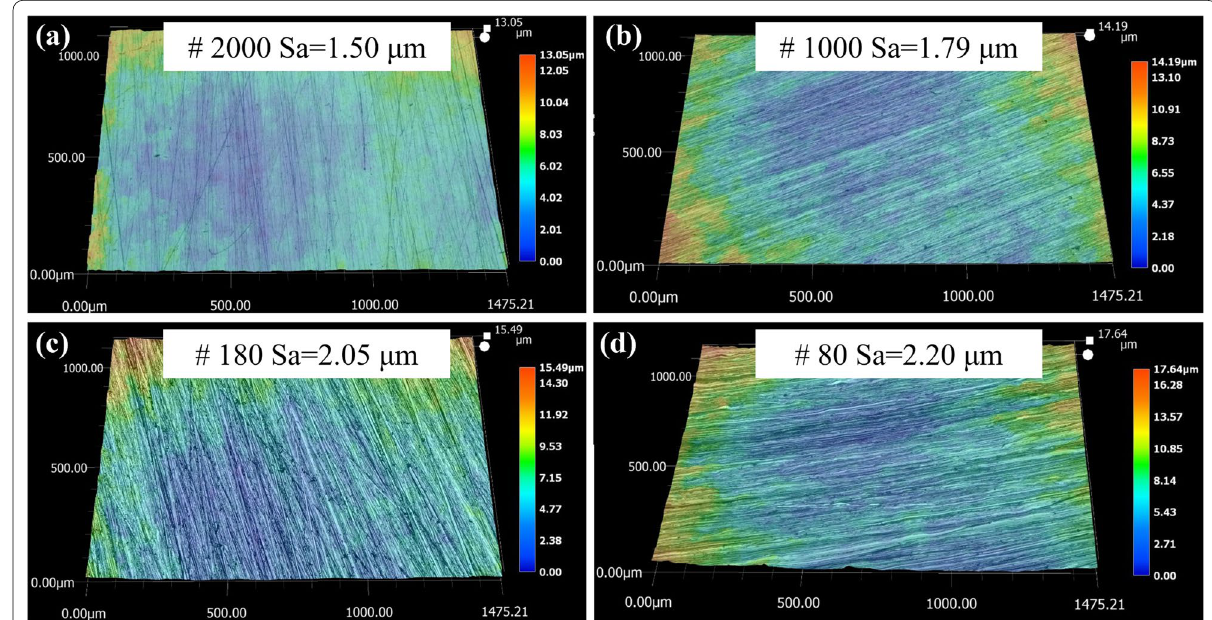
Figure 13 Surface morphology of the sample ground with abrasive papers of mesh sizes of ( a ) # 2000, ( b ) # 1000, ( c ) # 180, ( d ) #